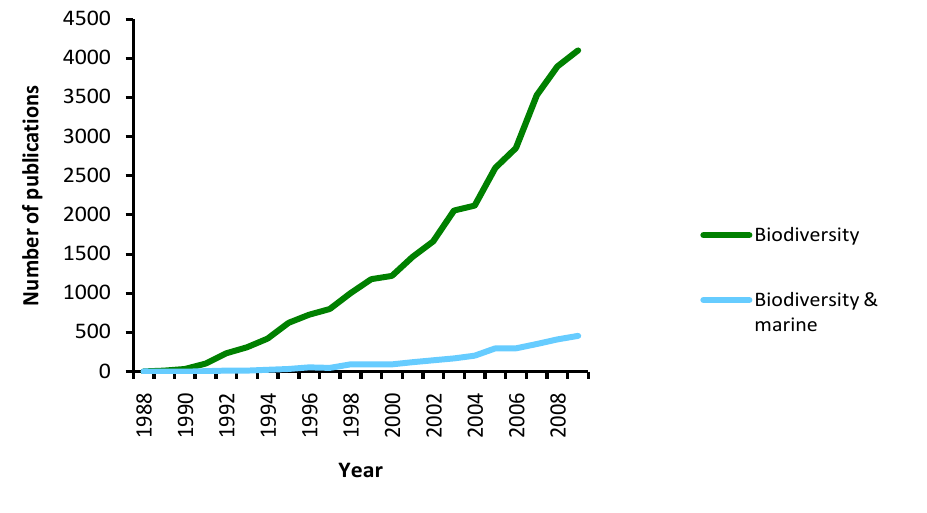
Figure 1. The amount of articles focusing on marine biodiversity since 1988 (‘biodiversity’ and ‘marine’ used as keywords in Web of